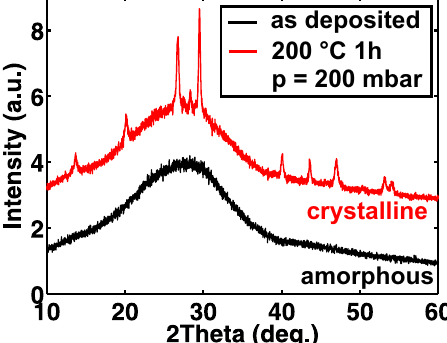
Figure 2. X-ray diffraction of 100-nm-thick GST on quartz